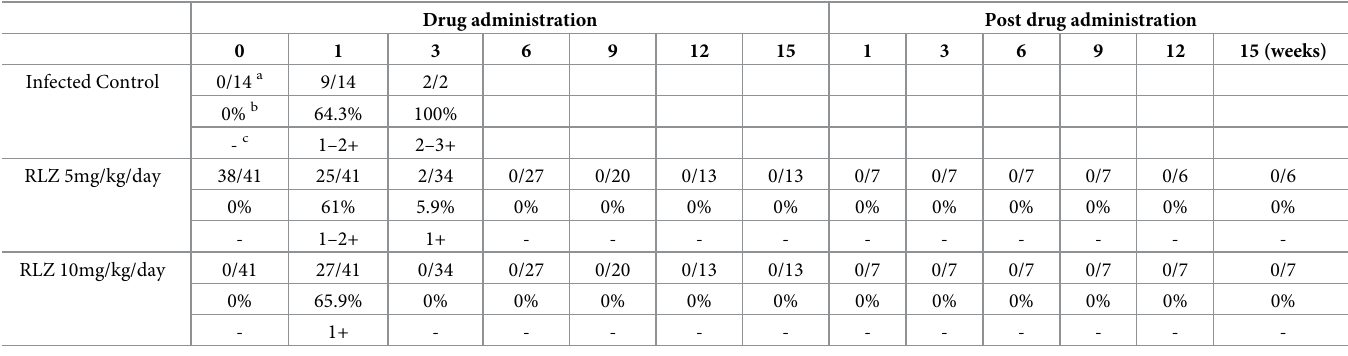
Table 2. Gross skin erosion of hind footpads in untreated and rifalazil-treated M . ulcerans infected mice. Drug